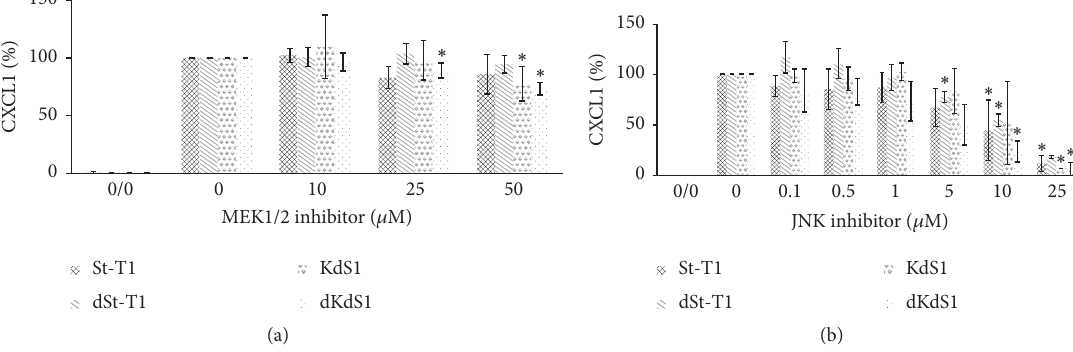
Figure 4: Quantitative analysis of CXCL1 protein secretion (%) of human EnS cell lines St-T1 and KdS1 measured by ELISA. (a + b) St-T1, dSt-T1, KdS1, and dKdS1 were treated with indicated concentrations of the inhibitors for 2 h, and subsequently the cells were incubated with IL-1 𝛽 for 48h (10ng/mL for nondecidualized and 0.1 ng/mL for decidualized cells). Shown are means ± SD with ∗ 𝑝 < 0.05 for treated cells versus untreated cells. Cells with no inhibitor but IL-1 𝛽 treatment served as controls (0) (=100% CXCL1 secretion); 0/0 cells (no inhibitor, no IL-1 𝛽 ) served as secretion controls